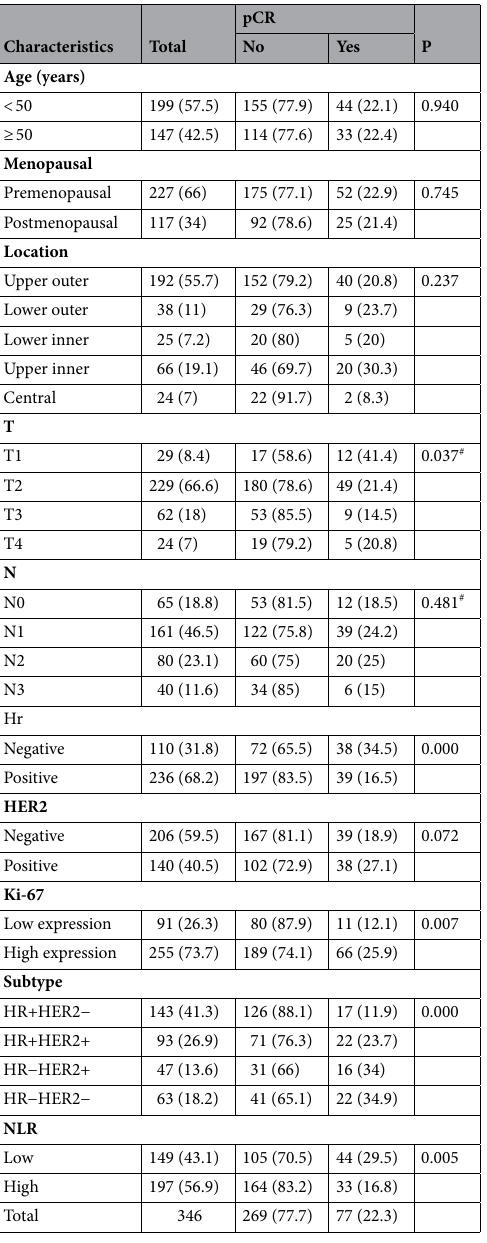
Table 2. Correlations between patient clinicopathological features and pCR after NCT (%). HR hormone receptor, HER2 human epidermal growth factor receptor 2, pCR pathologic complete response,